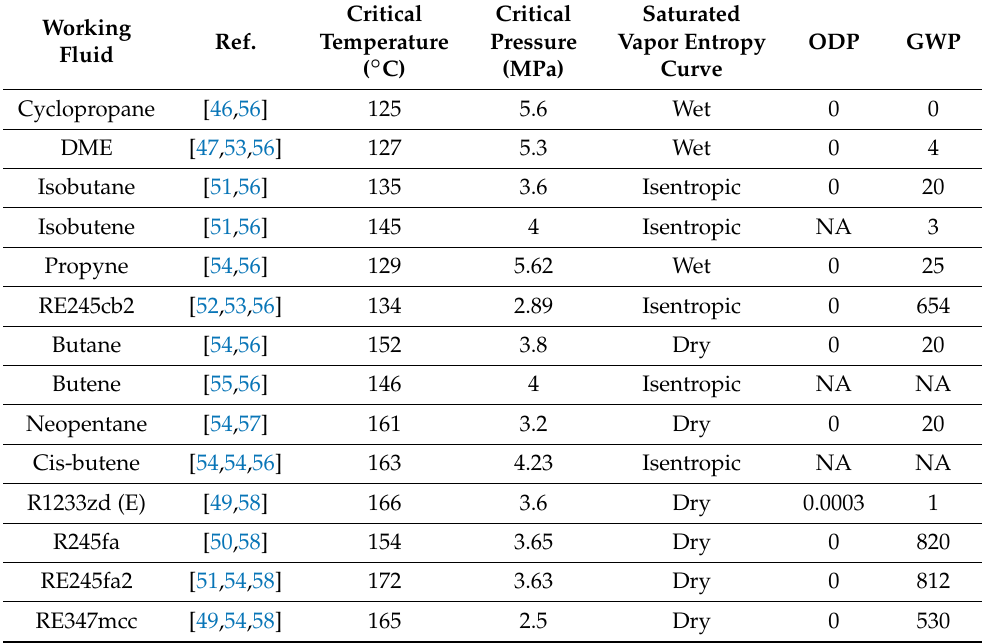
Table 3. Thermal and environmental properties of the selected working fluids.